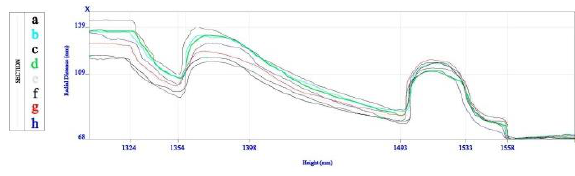
Figure 4. Sections and characteristic points